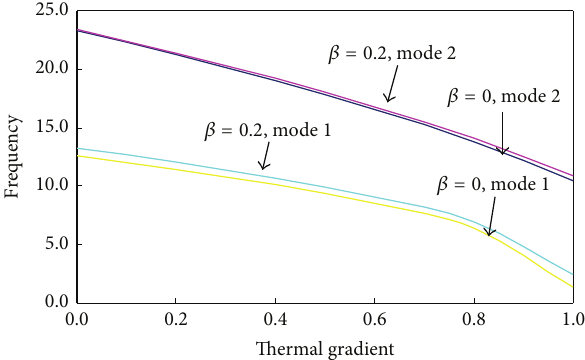
Figure 8: Value of frequency parameter for orthotropic trapezoidal plates for different values of thermal gradient and fixed values for 𝑎/𝑏 = 0.75 , 𝑐/𝑏 = 0.5 .